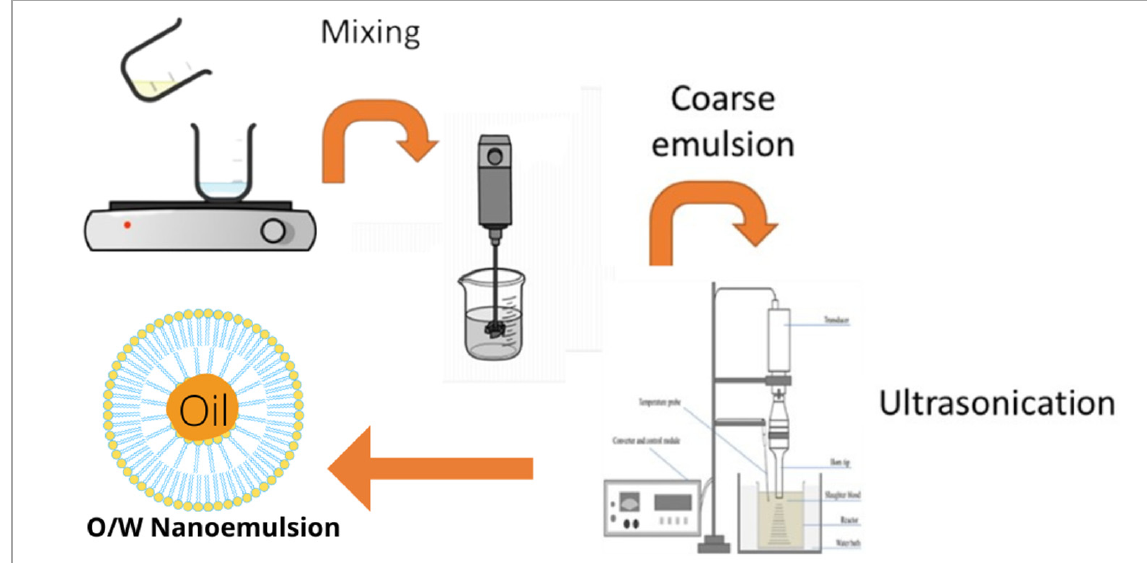
Figure 7. Schematic diagram of the preparation of NE-FLO using the ultrasonication method .